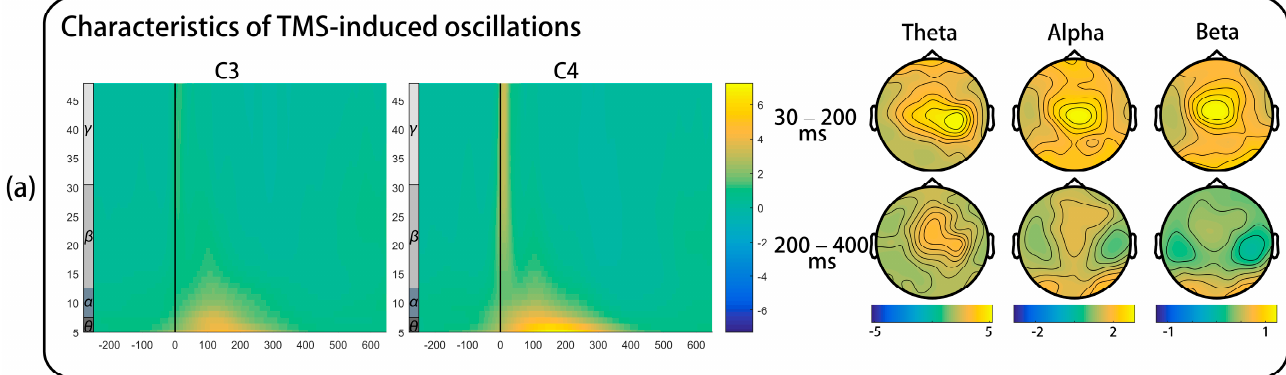
Figure 5. The effect of iTBS in TMS ‐ induced oscillations. The power of each frequency was normalized by dividing all time bins by the mean of baseline power ( − 650 to − 350 ms), and an absolute baseline correction was also carried out. ( a ) Only pre ‐ iTBS data of the M1 condition are presented. ( b ) Topographical plots are the difference of early (30–200 ms) and late (200–400 ms) oscillations. ( c ) The red rectangle indicates significantly decreased TMS ‐ induced early α‐ band oscillation. “*” represents electrodes with a significant difference. TMS: transcranial magnetic stimulation; iTBS: intermittent theta burst stimulation; M1: primary motor cortex; SMA: supplementary motor area; V1: primary visual cortex.